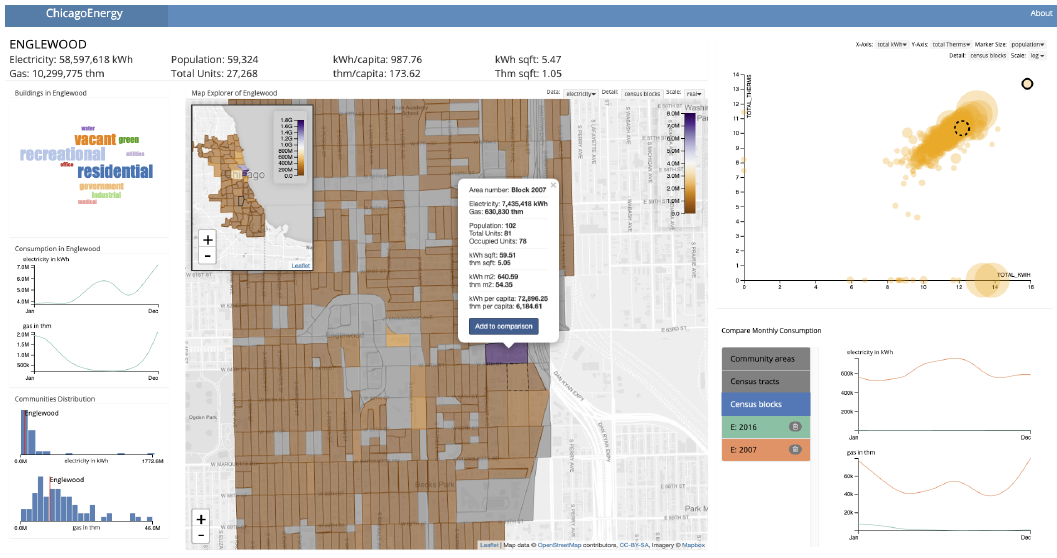
Figure 7. Local neighborhood analysis. An investigation of a disadvantaged urban neighborhood at the census block spatial scale is able to identify an outlier block with unusual electricity and gas consumption. The block’s profile is strikingly different when compared to an adjacent block that has similar census and building